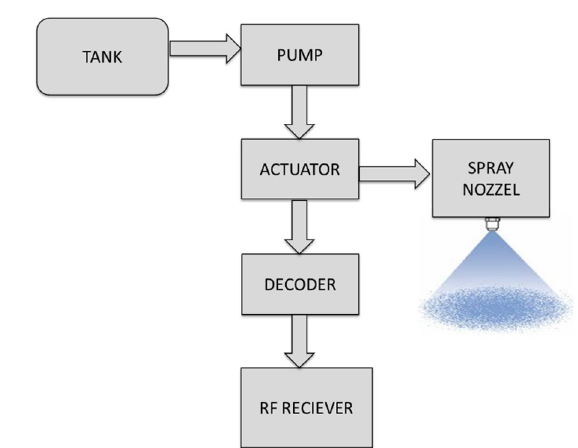
FIG. 1: FLIGHT CONTROL CHART